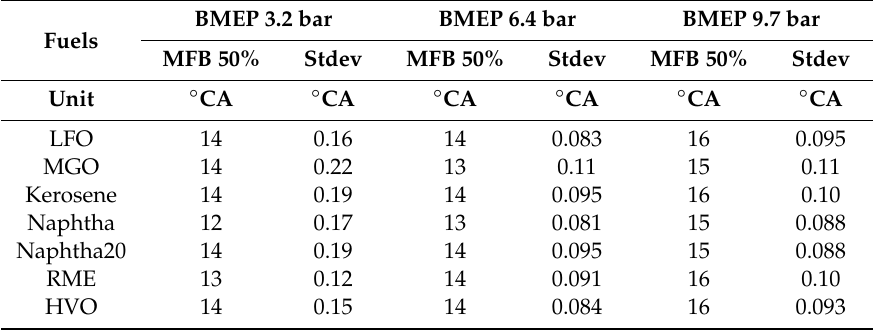
Table 5. Average values and standard deviations of mass fractions burned (MFB) 50%.